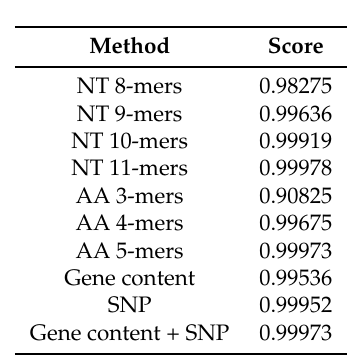
Table A65. Average feature stability scores of different methods methods across all species–antibiotic